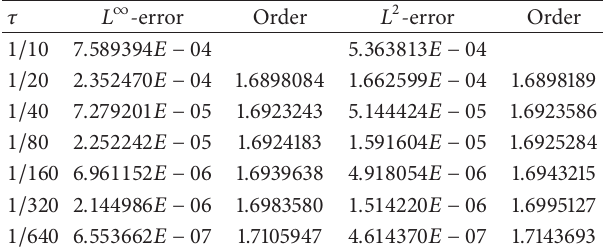
Table 1: Temporal errors and convergence orders with 𝛼 = 1.3 .